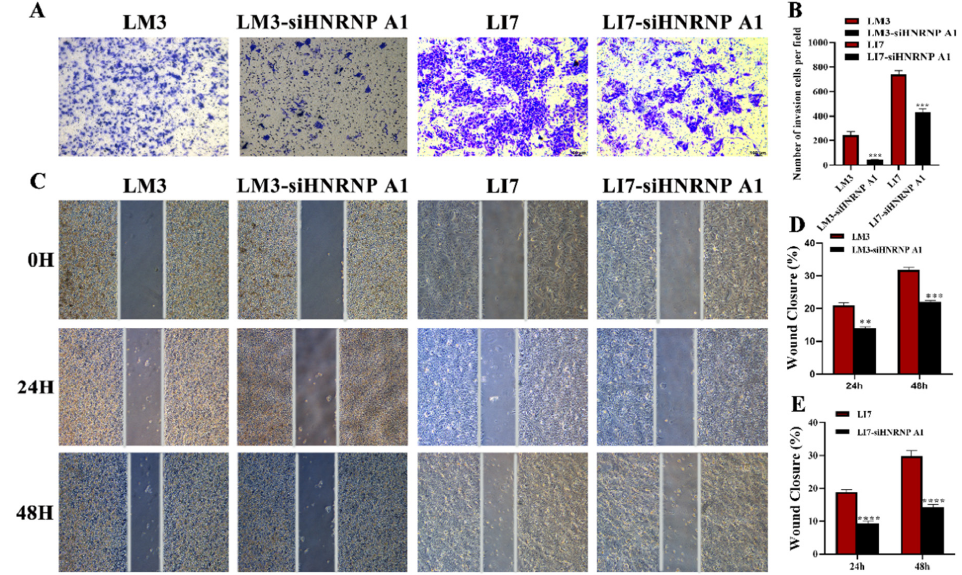
Figure 3. HNRNP A1 promotes the migration and invasion of HCC cells. ( A , B ) Matrigel invasion assays were used to examine the effects of HNRNP A1 on HCC cell invasion; the invasion capability was quantified as the cell number. Each picture was magnified 500 times by the microscope; ( C – E ) wound healing was performed to determine the ability of cell migration after knocking down HNRNP A1. Each picture was magnified 100 times by the microscope. ** p < 0.01; *** p < 0.001; **** p < 0.001. The data are expressed as the mean ± SD.